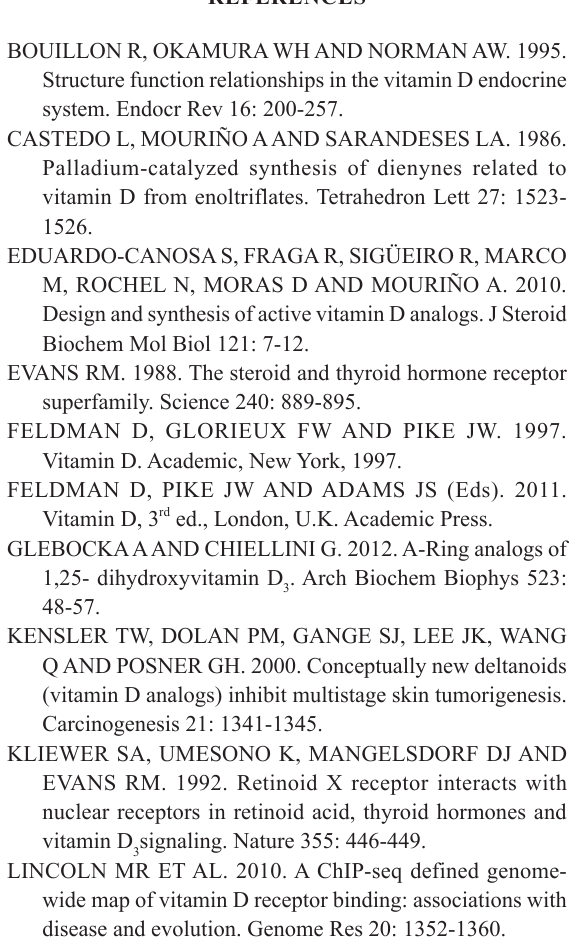
Figure 3 - Effect of Cr(CO) Horner